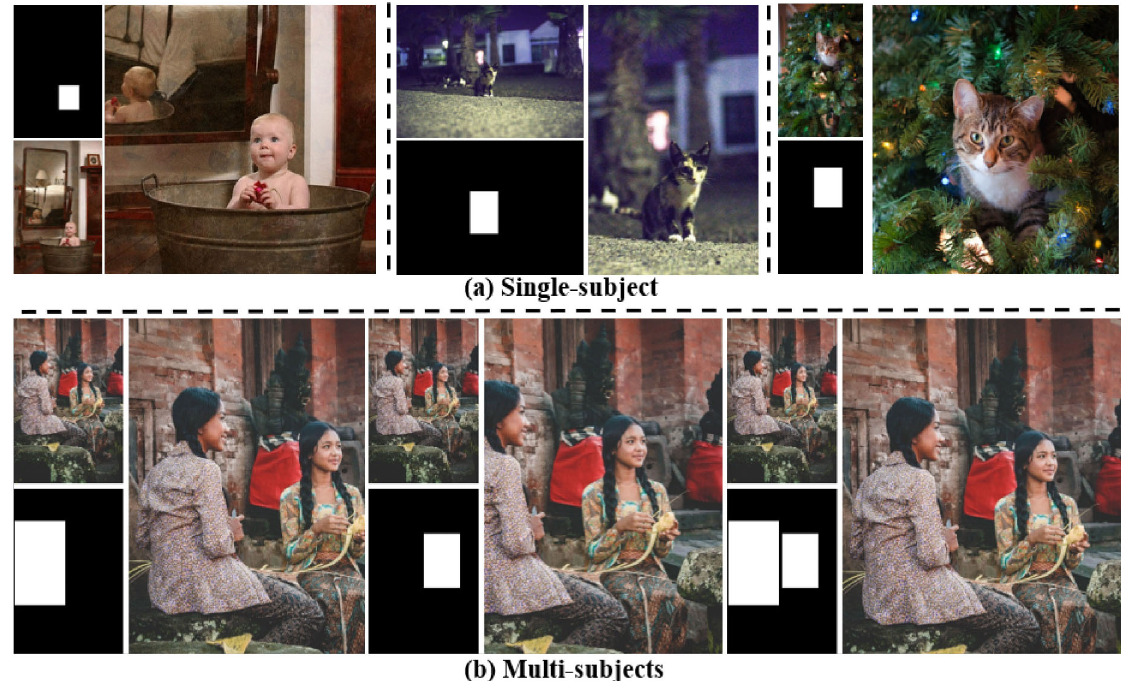
Fig. 1 Examples of SAC-Net. (a) Cropping examples for single-subject images. Given an original image and a subject’s window mask, our method can recommend a sub-image with high aesthetic value. (b) Cropping examples for multi-subject images. Different composition results are obtained for different input subject window